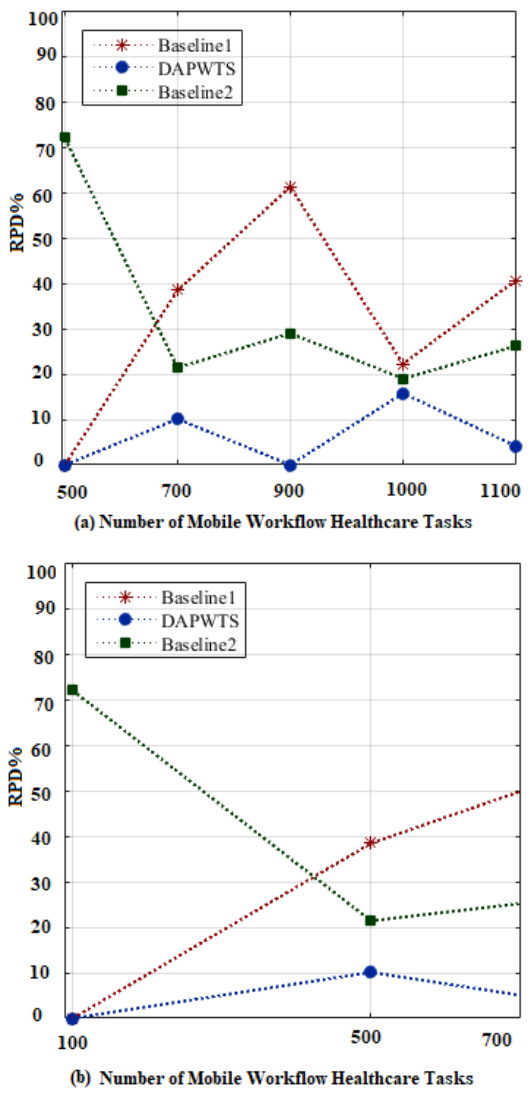
Figure 7. Application partitioning performance and task